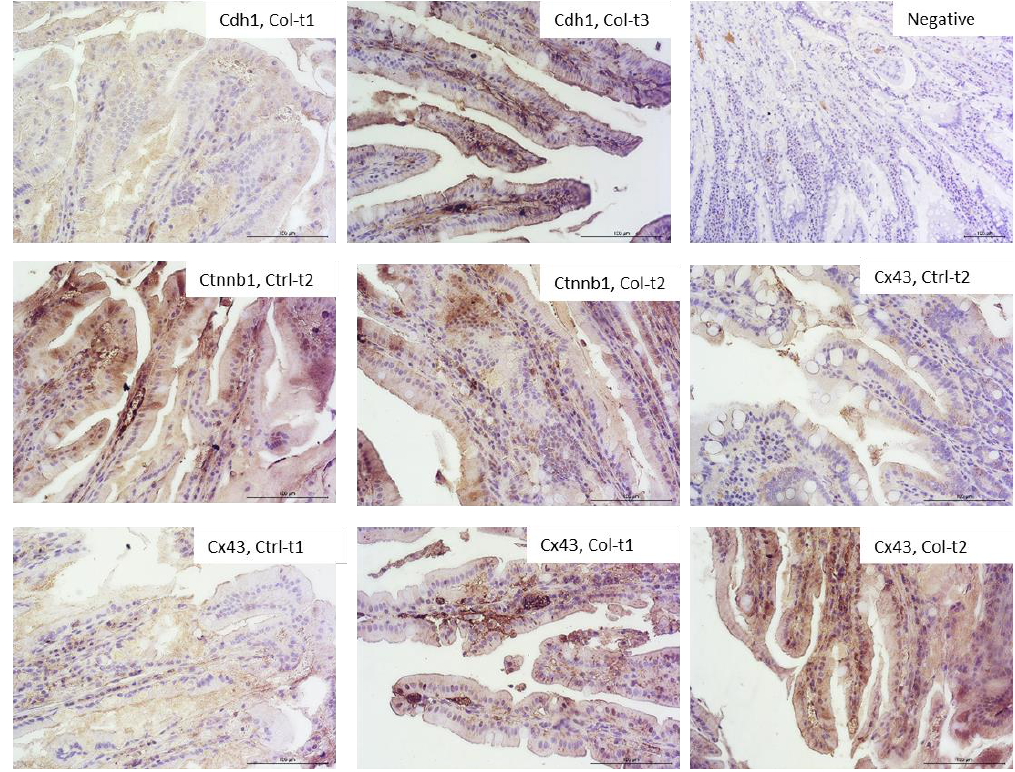
Figure 4. Representative pictures of the protein expression of intercellular junctions in the small intestine derived from control or Col-supplemented animals. We have only selected those where the differences were most apparent (objective magn. x20, Leica DM5000B, Wetzlar, Germany).